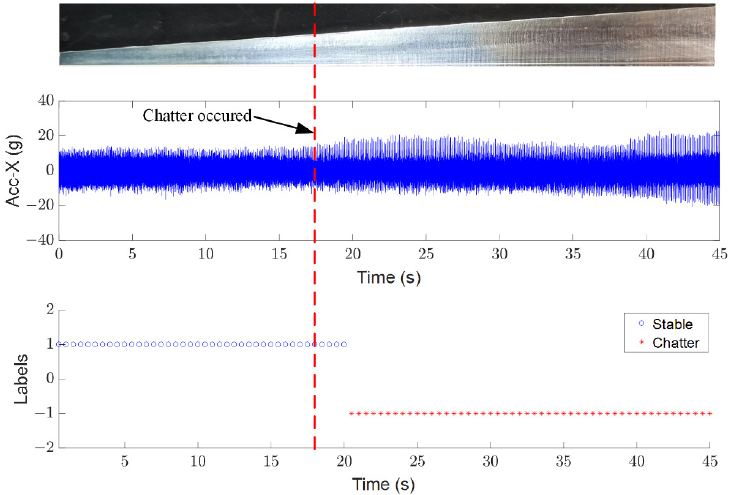
Figure 10. Chatter identification results with proposed method (spindle speed 6800 rpm, feed rate 450 mm/min, and radial cutting depth 2 mm).